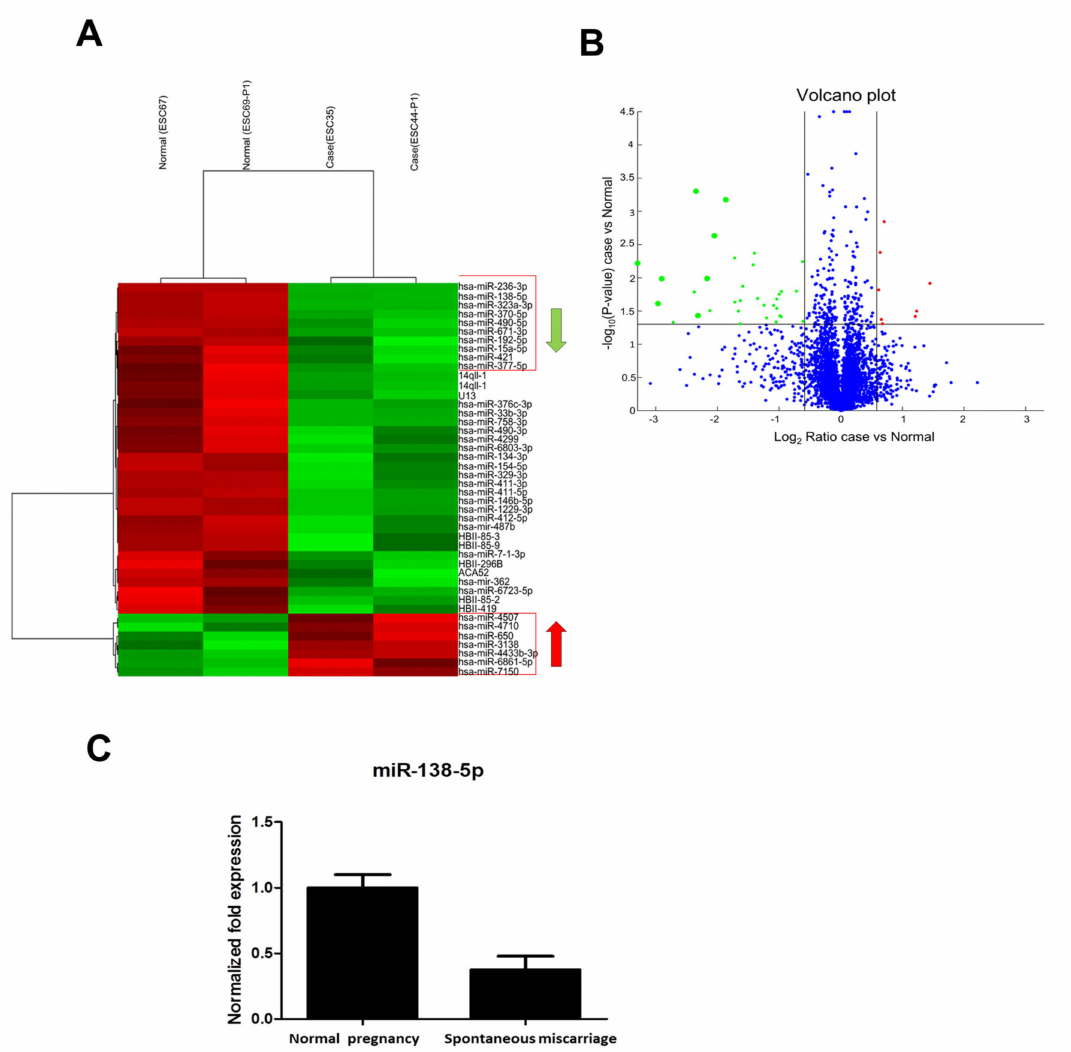
Figure 2. The microarray analysis of miRNAs for endometrial tissue. Total RNA of endometrial stromal cells was purified. The miRNA expression profiles were analyzed using the Affymetrix Gene-Chip miRNA 4.0 array. ( A ) Differential expression of miRNAs between normal pregnancy and spontaneous miscarriage in a hierarchical clustering analysis. The red color indicates up- regulation, and the green color indicates down-regulation. To identify miRNA expression signatures, we performed miRNA microarray analysis in endometrial tissue. Hierarchical clustering analysis revealed a significant down-regulation of 8 miRNAs and up-regulation of 7 miRNAs in spontaneous miscarriage ESC compared to normal pregnancy ESC. ( B ) Volcano plot of microarray data. Plot shows differences between normal pregnancy and spontaneous miscarriage. Differentially expressed miRNAs with a fold change ≥ 1.5 and p < 0.05 between the two groups are shown in red and green. ( C ) RT-qPCR analysis of the expressed miRNA. Total extracellular vesicle RNAs were reverse transcribed to cDNA with primers for miR-138-5p and U6 small nuclear RNA. miR-138-5p is down- regulated in spontaneous miscarriage compared to normal